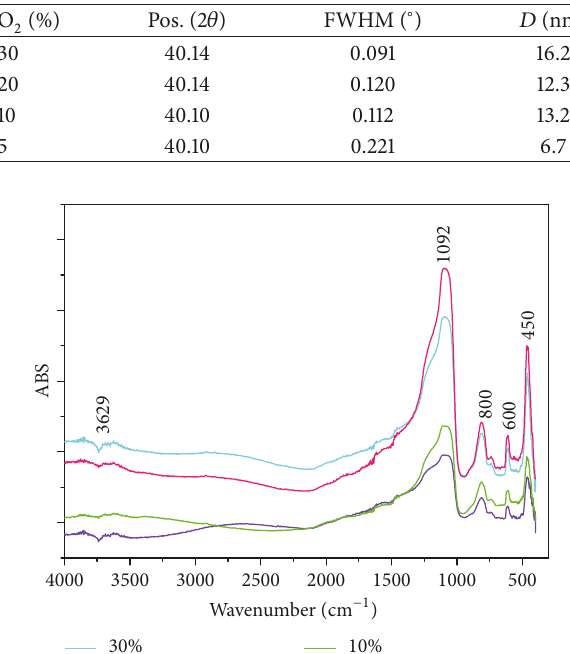
Table 2: Grain size of rutile with (111) orientation at different O 2 flow rate.